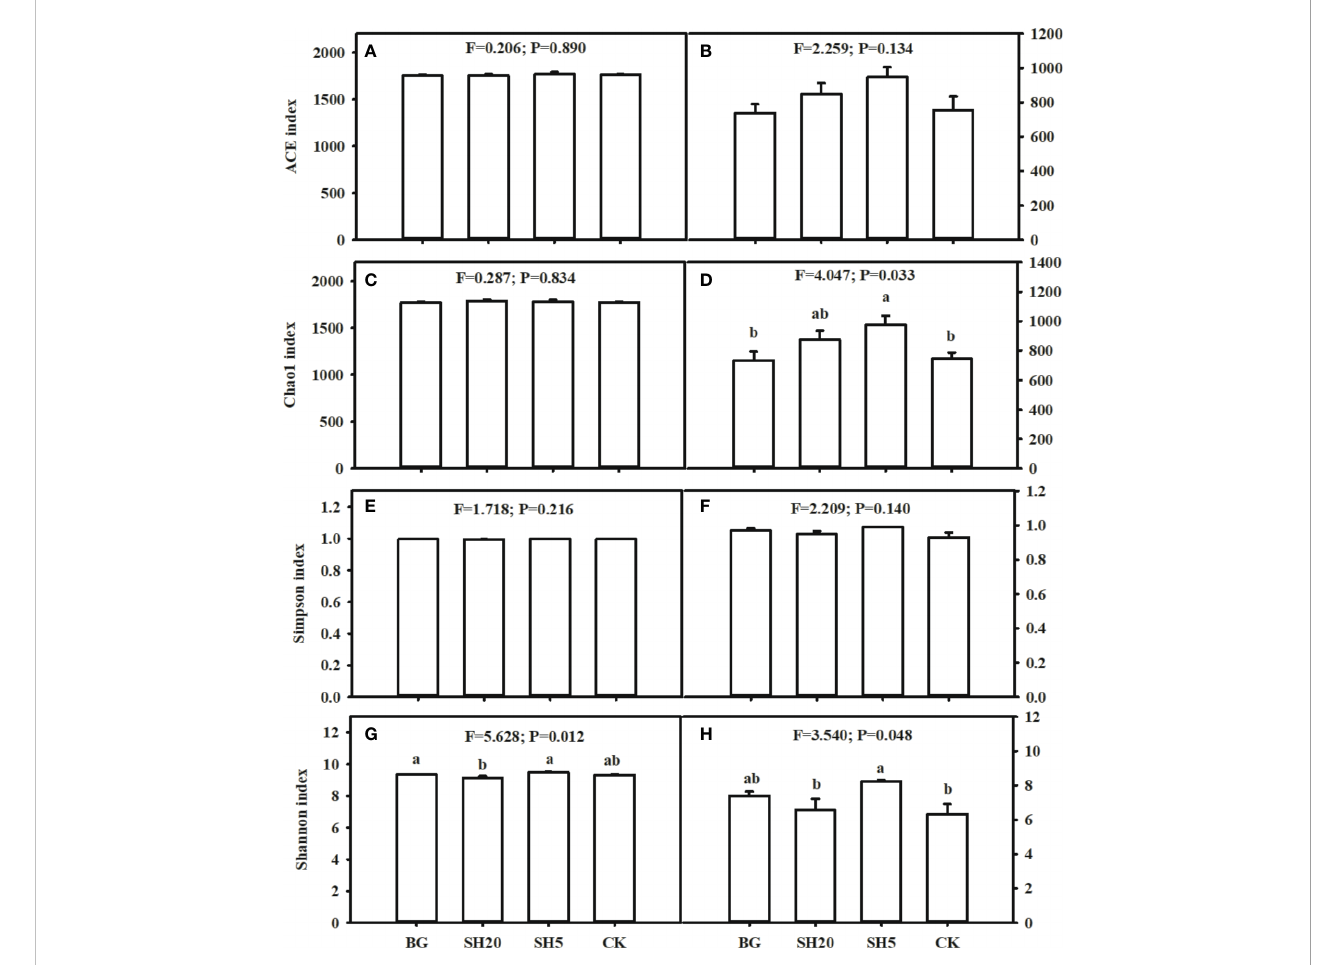
FIGURE 4 Alpha diversity index in the BG, SH20, SH5 and CK treatments. Left: Bacterial community diversity (A, C, E, G) ; Right: fungal community diversity (B, D, F, H) . Within each subgraph according to Tukey ’ s mean separation test, values with the same lower case presents a non-signi fi cant difference (p = 0.05), while different lower-case letters show a signi fi cant (p < 0.05)